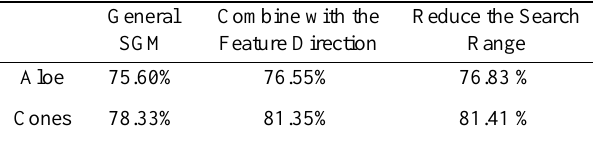
Table 2. Accuracy of improved functions for Cones and Aloe